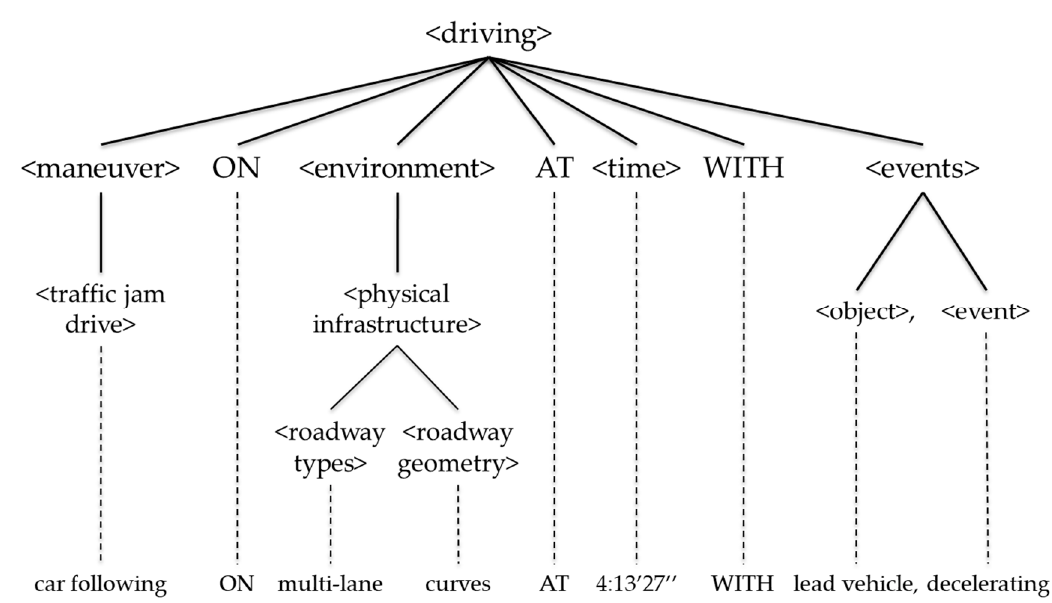
Figure 3. The parsing tree of a driving-state expression.